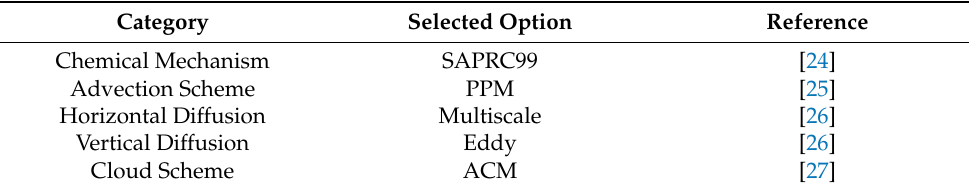
Table 2. Summary of CMAQ